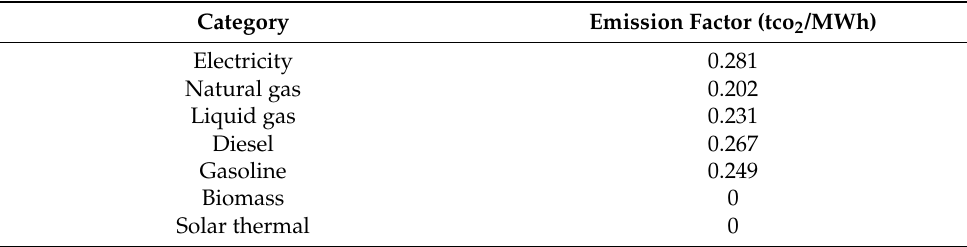
Table 4. Specific emissions factors (tons of CO 2